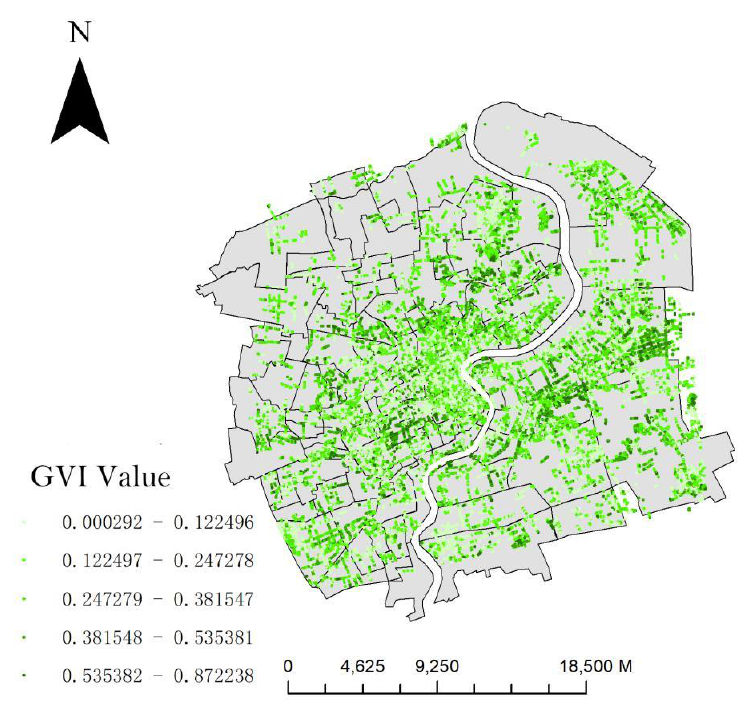
Figure 7. Green-view value of each sampling point. Table 3. Descriptive statistics of green-view values.